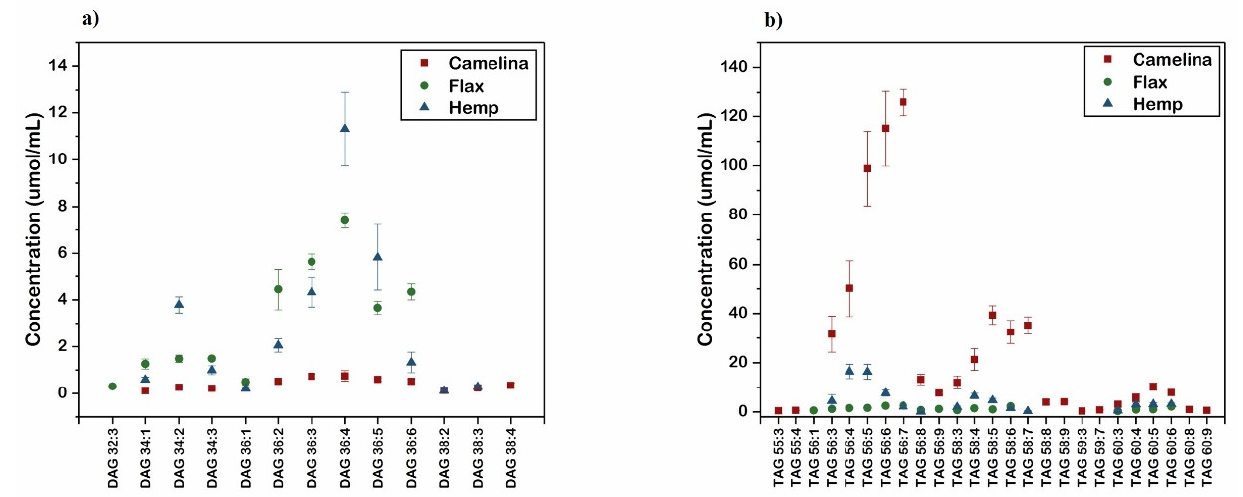
Figure 3. The DAG ( a ) and TAG ( b ) possible differentiation markers of the three oils.